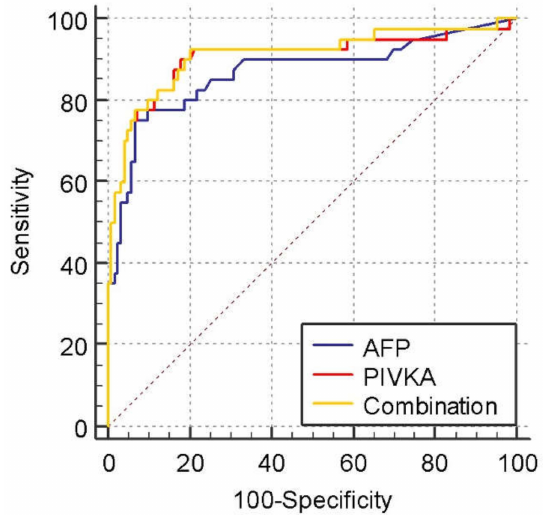
Figure 1. The AUROC curve of PIVKA-II (0.905, 95% confidence interval [CI], 0.849 to 0.945, p < 0.0001) was higher than that of AFP (0.869, 95% CI, 0.807 to 0.916, p < 0.0001), but their combination gave the highest AUROC value (0.911, 95% CI, 0.856 to 0.950, p < 0.0001) in differentiating HCC from NMHR. However, their differences were not statistically significant (AFP vs. PIVKA-II; p = 0.4775, AFP vs. Combination; p = 0.3808, PIVKA-II vs. Combination; p = 0.2268).